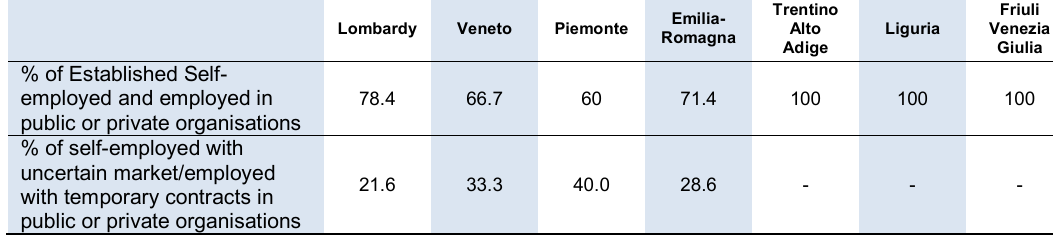
Table 5 - Geographical distribution of interviewed and their positioning in the job market. Data per region of origin. n =